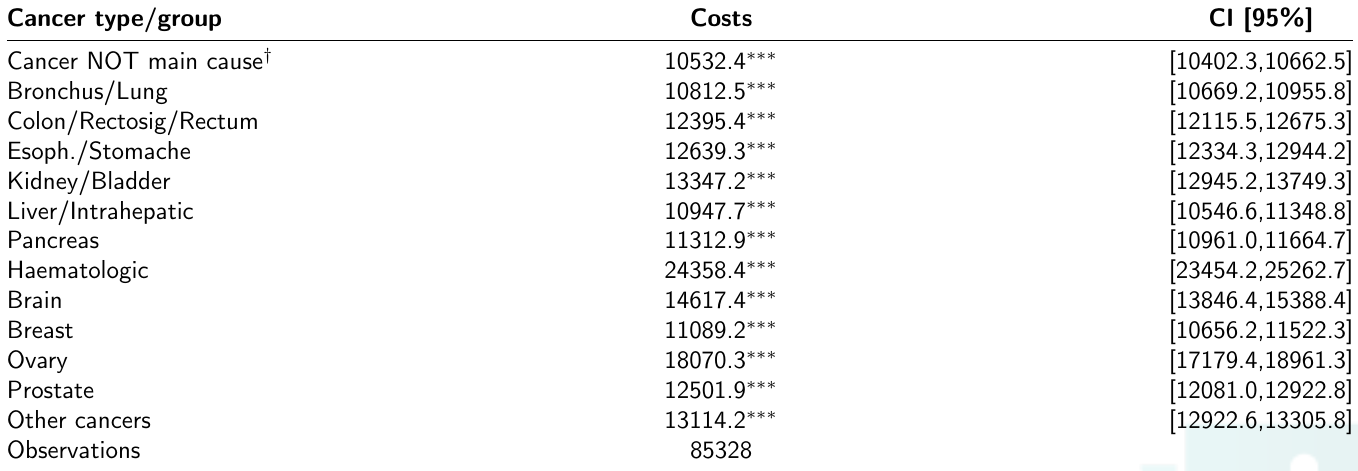
Supplementary Table 4: Univariate analysis GLM – Cancer type